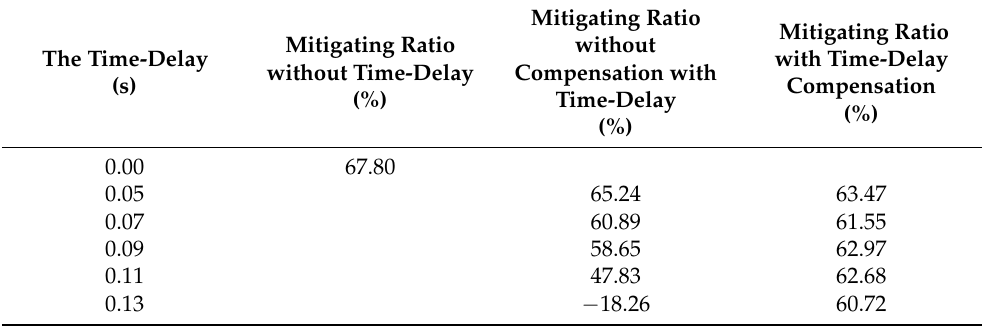
Table 7. Experimental response reductions at mid-span under random excitation.